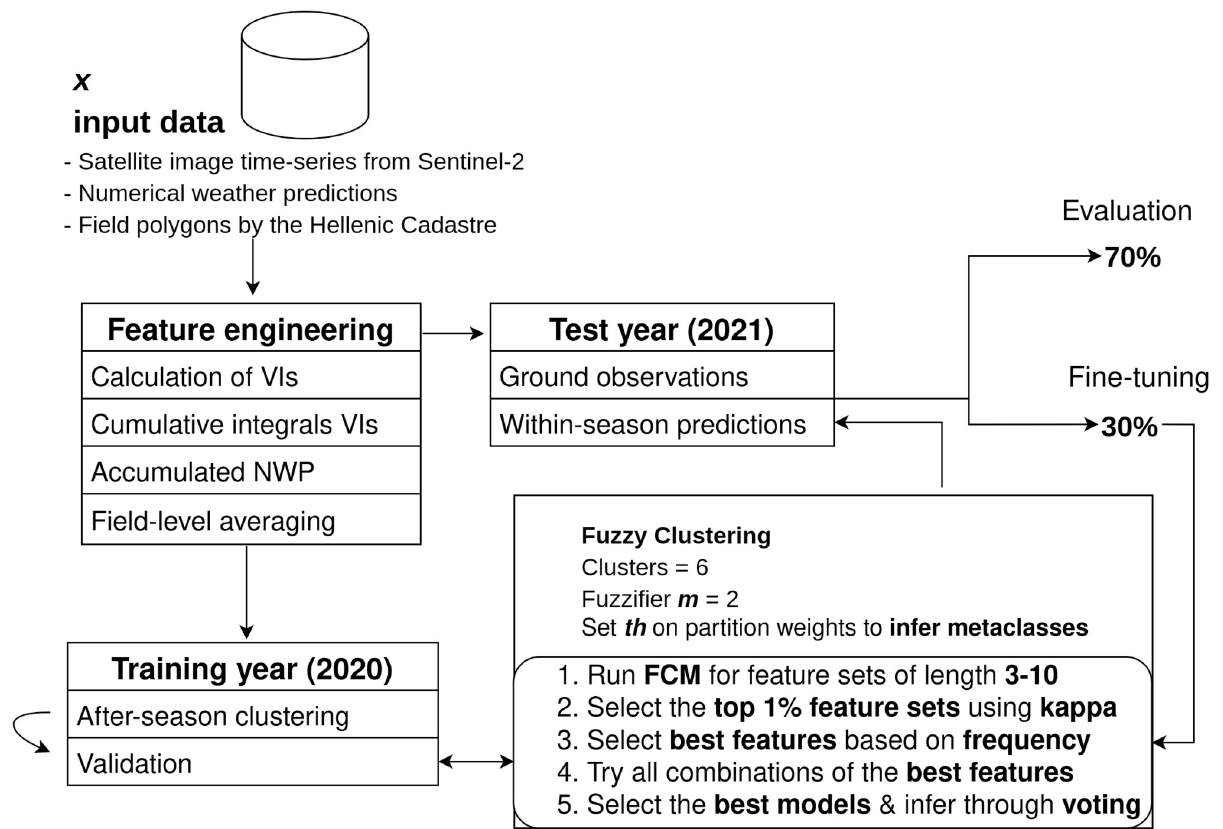
Fig 5. The proposed methodology for cotton phenology